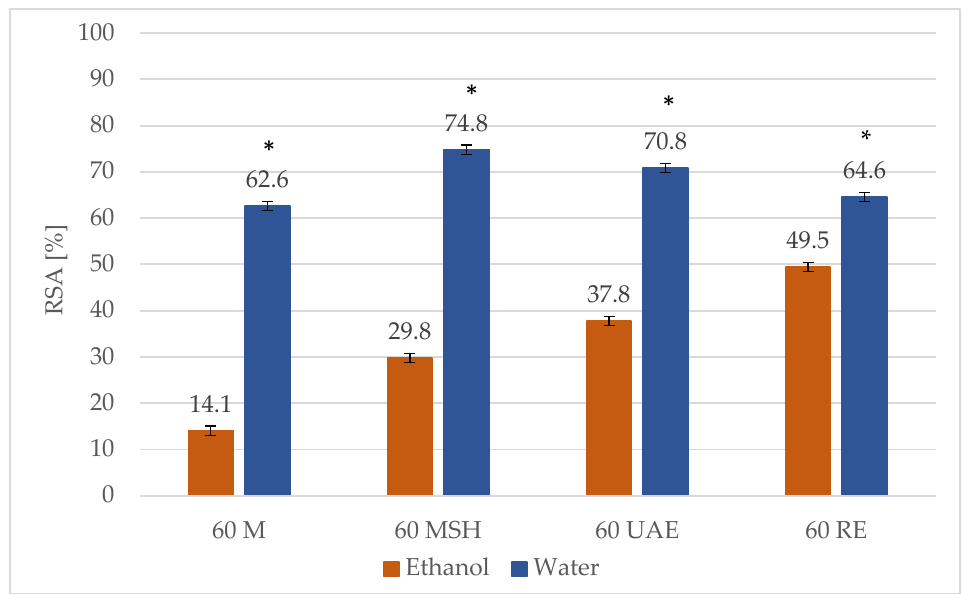
Figure 3. Comparison of RSA values for maca extracts obtained in 60-min extraction processes using 96% ethanol and water as the solvent (M—maceration; MSH—maceration with shaking; UAE—ultrasound-assisted extraction; RE—reflux extraction); * statistically significant differences among the results obtained using two different solvents at p < 0.05.